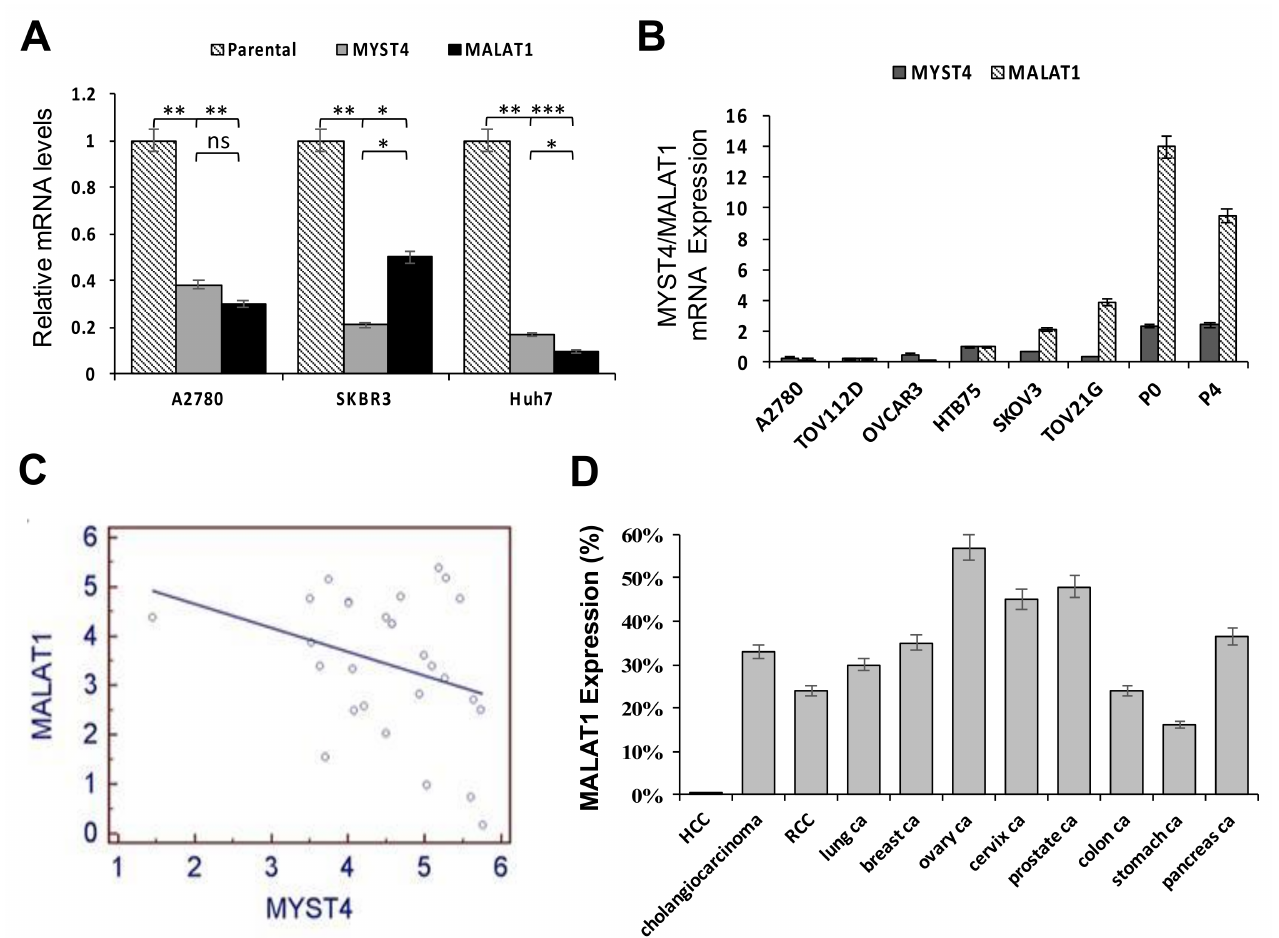
Figure 1. Relative expression levels between MYST4 and MALAT1, and levels of MALAT1 in various types of human cancer tissues: ( A ) Relative expression levels between MYST4 and MALAT1 were detected by an RT-qPCR after MYST4-knockdown in the A2780, Skbr3, and Huh7 cell lines (* p < 0.05; ** p < 0.01; *** p < 0.001). ( B ) Relative expression levels between MYST4 and MALAT1 were measured using an RT-qPCR in the A2780, TOV112D, OVCAR3, HTB75, SKOV3, and TOV21G ovarian cancer (OC) lines and the P0 and P4 endometrial carcinoma cell lines. mRNA expressions were normalized by the level in HTB75 cells. ( C ) Correlated expression levels between MYST4 and MALAT1 in 26 ovarian carcinoma tissue samples were calculated using Pearson’s correlation analysis, but no significant correlations (r = 0.3175, p = 0.0997) between the two genes were found. ( D ) MALAT1 expression among 11 types of human carcinomas, including hepatocellular (HCC), cholangiolar, renal cell (RCC), lung, breast, ovarian, cervical, prostatic, colon, stomach, and pancreatic carcinomas by in-situ hybridization on tissue microarrays. Ovarian cancer (OC) showed the highest frequency of MALAT1